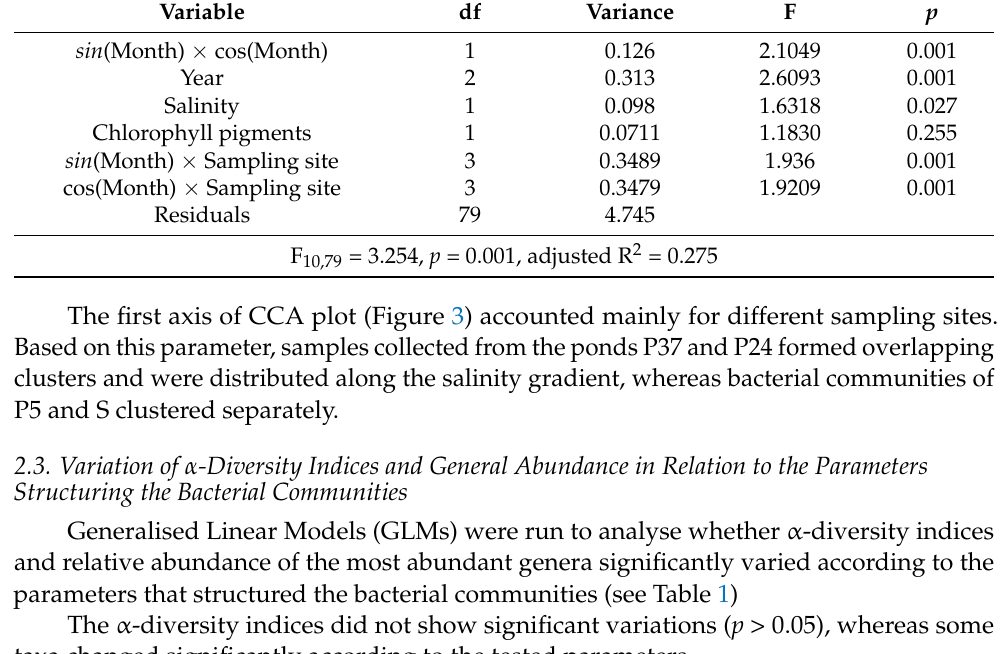
Table 1. Canonical Correspondence Analysis (CCA) of variation of the operational taxonomic units (outs) abundance for sea, P5, P24 and P37 according to the parameters. Variable df Variance F p sin (Month) × cos(Month) 1 0.126 2.1049 0.001